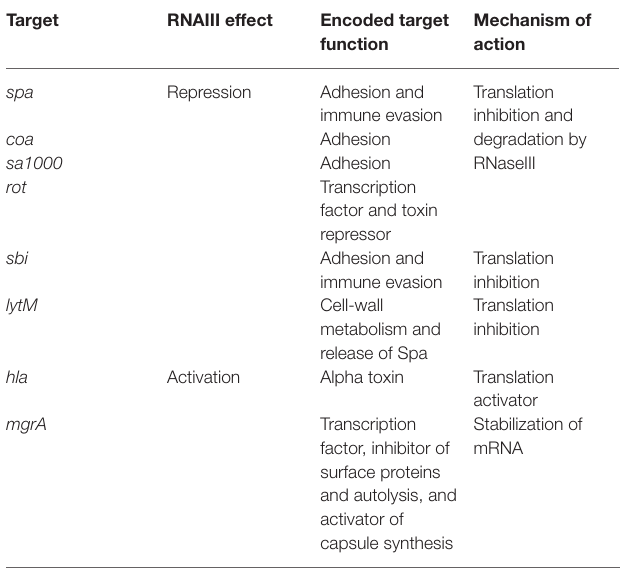
TABLE 1 | Targets regulated by RNAIII. Target RNAIII